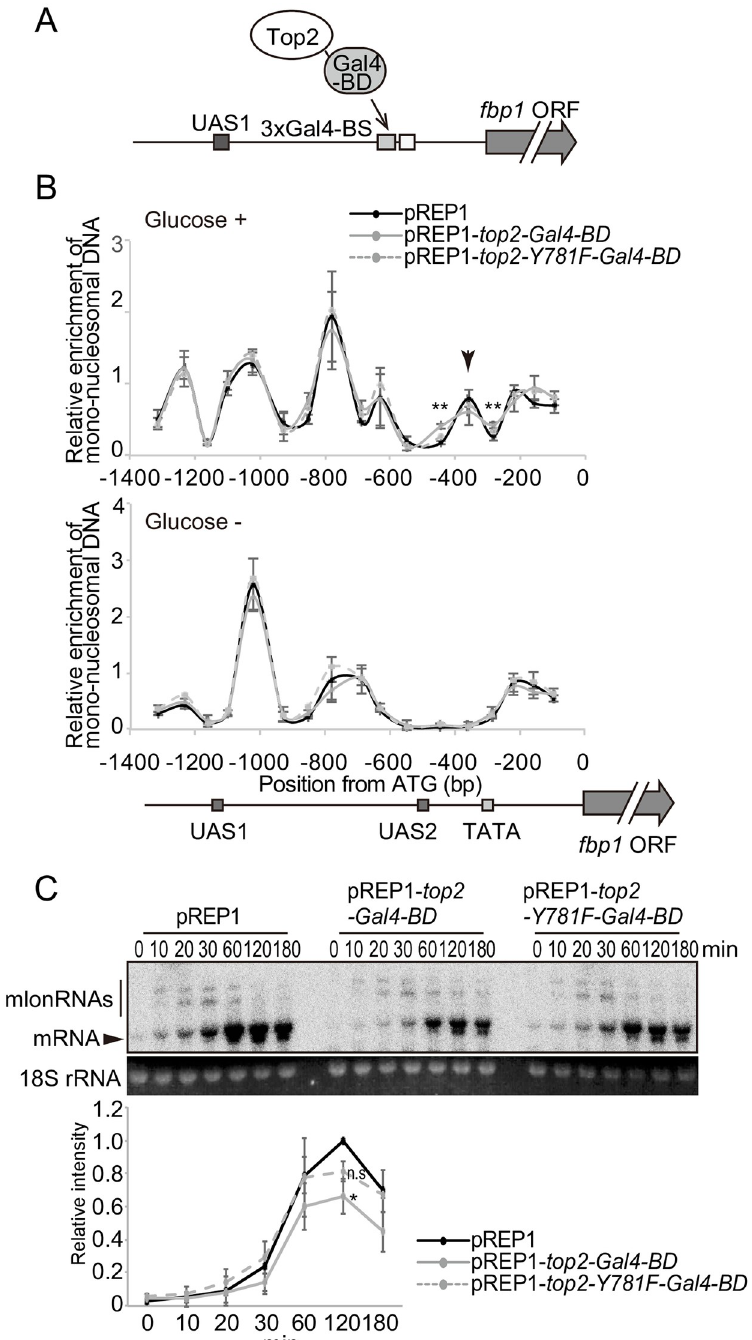
Fig 6. Forced recruitment of topoisomerase to UAS2 causes local destabilization of nucleosomes. (A) Schematic representation of Top2 tethering using Gal4-BD. Three copies of Gal4-binding sequences (BS) were inserted at the upstream adjacent region of UAS2. Gal4-BD was fused to the C-terminus of Top2 expressed from plasmid. (B) Gal4-BD fusion mediated tethering of Top2 to UAS2 causes local destabilization of nucleosome positioning only around UAS2. The mono-nucleosomes were analyzed as in Fig 4. p -value was calculated by a Student’s t -test: �� , p < 0.01 (C) Transcription of fbp1 gene during the course of glucose starvation in cells carrying pREP1, pREP1- top2-GAL4-BD , or pREP1- top2 - Y781F-GAL4-BD . The cells were cultured in SD (repressed condition). 18S rRNA was used as a loading control. The band intensities of fbp1 mRNA were quantitated and normalized for the intensity of 18S rRNA. The error bars indicate standard deviation in at least two biological replicates. p -value was calculated by a Student’s t -test: � , p < 0.05; n.s, not significant. https://doi.org/10.1371/journal.pone.0242348.g006 PLOS ONE | https://doi.org/10.1371/journal.pone.0242348 November12,